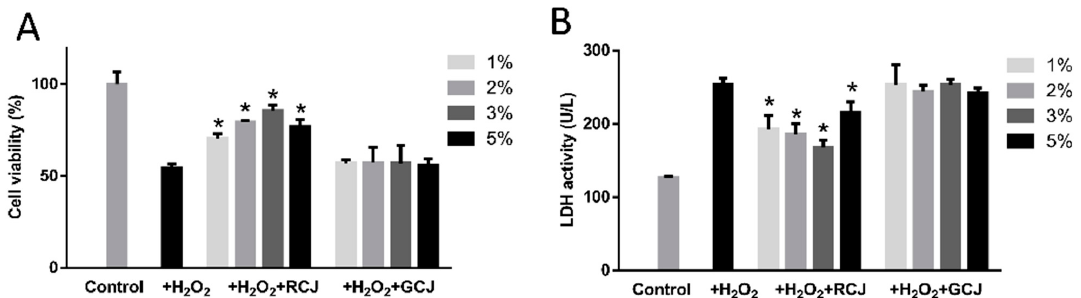
Figure 2. Effect of red cabbage juice (RCJ) and green cabbage juice (GCJ) on the cell viability ( A ) and lactate dehydrogenase (LDH) release ( B ) in H 2 O 2 -induced caco-2 cells. Data are presented as mean ± SD. * p < 0.05 vs. control by one-way ANOVA followed by Bonferroni correction.